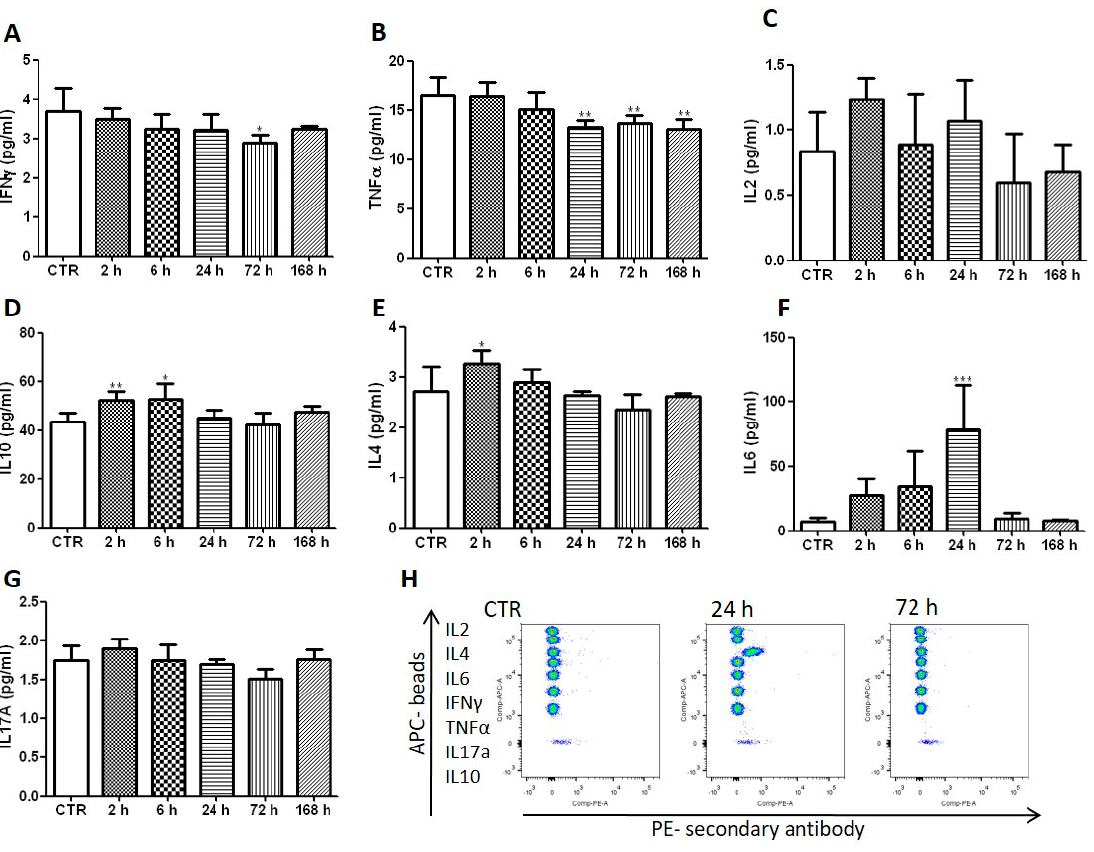
Figure 2. Redaporfin-PDT increases the blood levels of the pro-inflammatory cytokine IL6. The quantification of different cytokines ( A ) IFN- γ ; ( B ) TNF- α ; ( C ) IL-2; ( D ) IL-10; ( E ) IL-4; ( F ) IL-6; ( G ) IL-17A) was performed in the blood at different time points after vascular-PDT. ( H ) Representative dot plots depict the different cytokines in untreated and treated mice. Bars are the mean ± SD of five mice. No symbol: p > 0.05; * p < 0.05; ** p < 0.01; *** p < 0.001.